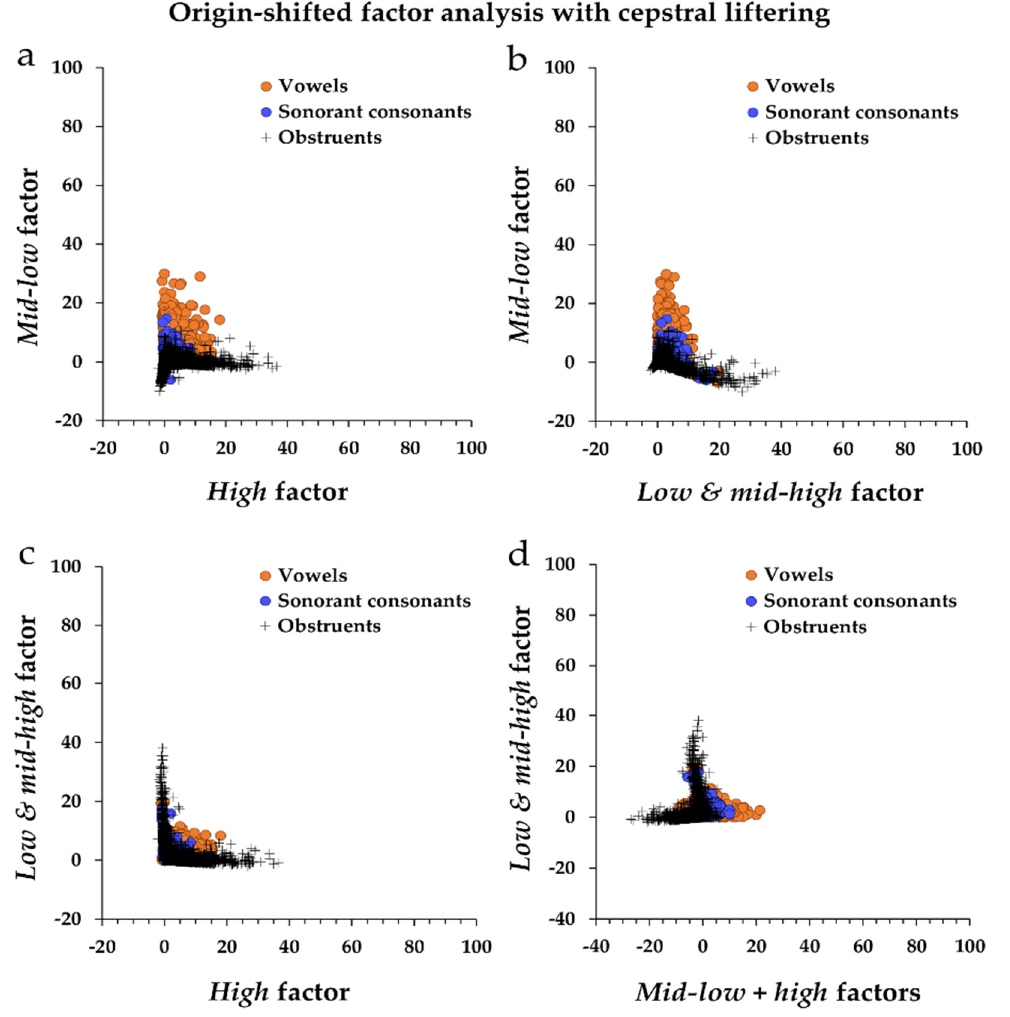
Figure 2. The distribution of the factor scores by origin-shifted factor analysis with cepstral liftering, following Kishida et al. (2016) [12]. ( a – c ) represent all possible combinations of two factors out of the three factors, and ( d ) shows a two-dimensional mapping of the three factors.